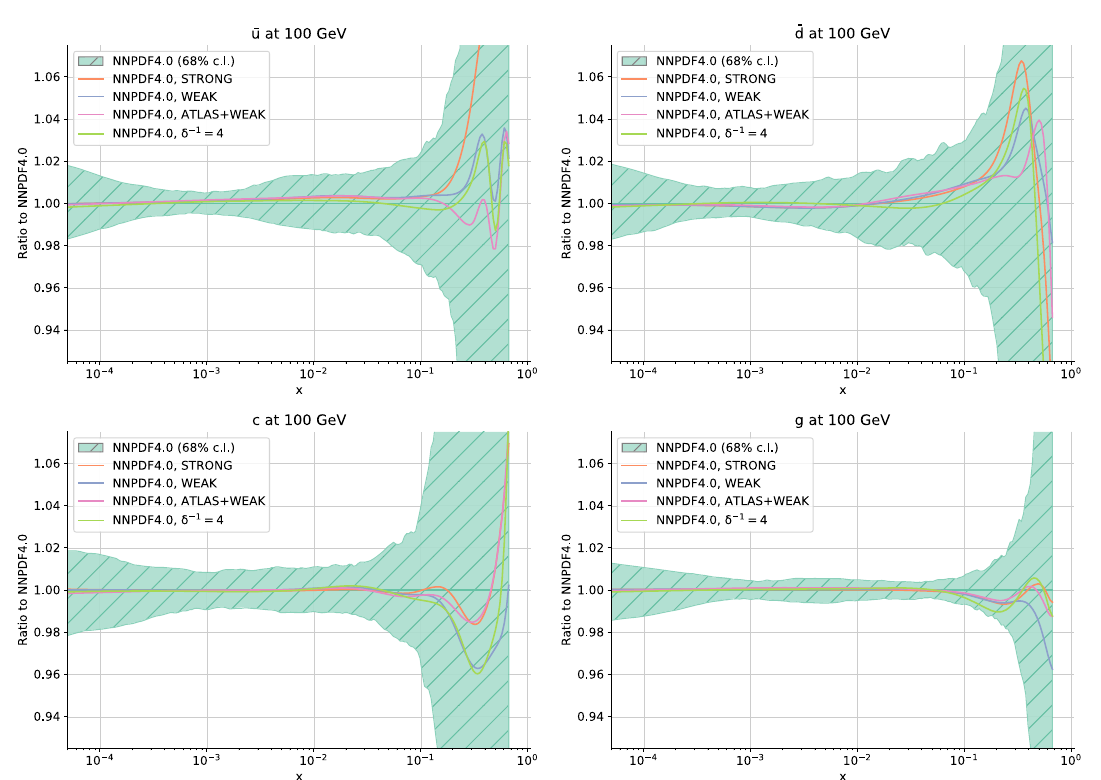
Fig. 6 ThePDFsobtainedbyfittingtheNNPDF4.0datasetwithcorre- lation models provided by the experiment for a subset of measurements (see text for details). From top to bottom, left to right, we show the anti-up, anti-down, charm and gluon PDFs at a scale Q = 100 GeV. PDFs are compared to the NNPDF4.0 baseline parton set, and nor-